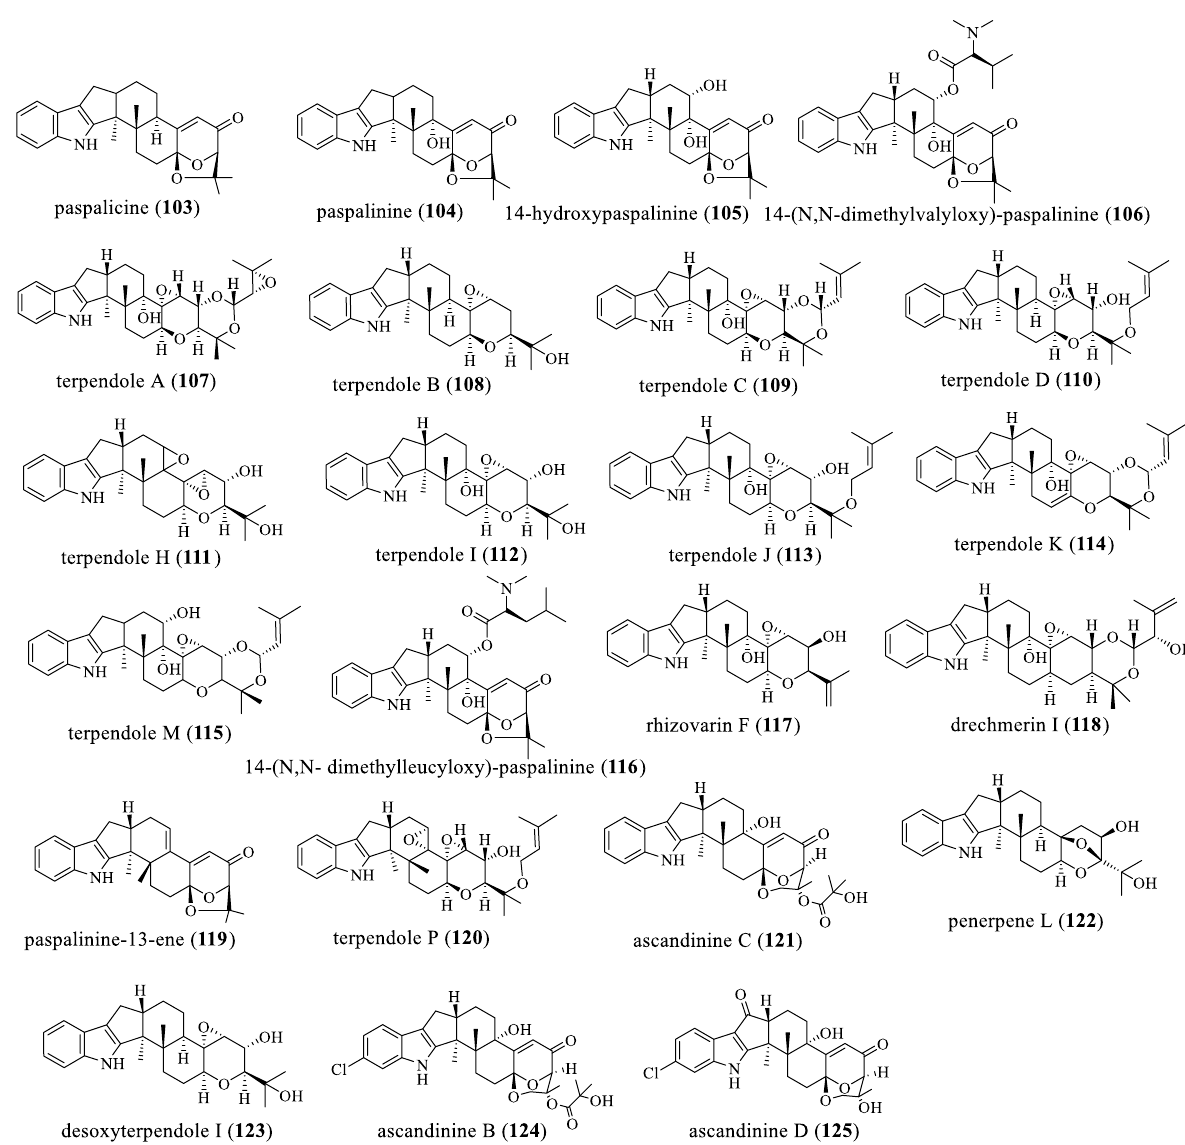
Fig. 8 Chemical structures of paspaline‑type compounds with F‑ring